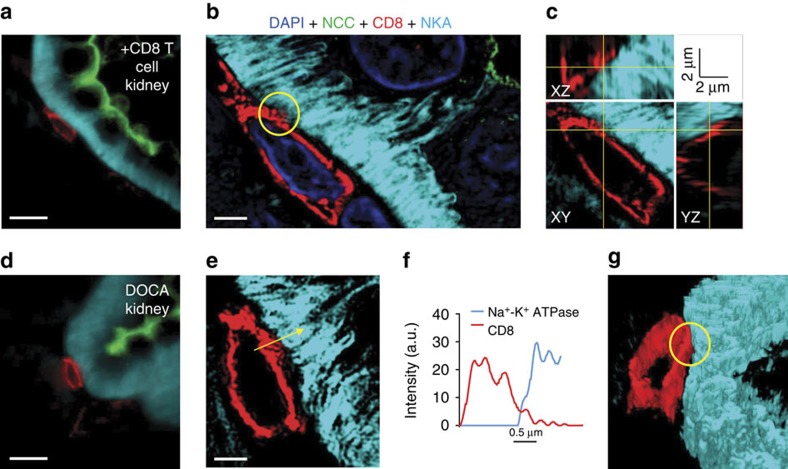
CD8+ T cells form close contacts with distal convoluted tubules in mouse kidney sections.(a) A wide-field image of a kidney section from a mouse injected with CD8+ T cells. Scale 10 μm. Antibodies against NCC (green), CD8 (red), and Na+-K+-ATPase-α (NKA, imaged far red and pseudo-colored cyan for visual clarity) were used. (b) The same CD8+ T cell from (a) processed with 3D structured illumination microscopy (3D-SIM). Scale, 2 μm. Four colour channel images were overlaid: DAPI (blue), NCC (green), CD8 (red), and NKA (cyan). The yellow circle denotes the putative contact point. (c) Orthogonal sections of the 3D image (XZ, XY, YZ) of the same cell. Yellow lines on each section correspond to the position of other orthogonal sections centred around the contact point. (d) A wide-field image of a kidney section from a DOCA-salt mouse. Identically stained as in a. Scale 10 μm. (e) 3D-SIM processed image of (d). Scale 2 μm. Yellow arrow represents the location and direction of intensity profile. (f) Fluorescence intensity profile of CD8 (red) and NKA (cyan) along the yellow arrow in e. (g) Three-dimensional surface rendering of the image shown in e. The yellow circle denotes the putative contact point. Data are representative of 11 images from +CD8 T cell group and 13 images from DOCA group.